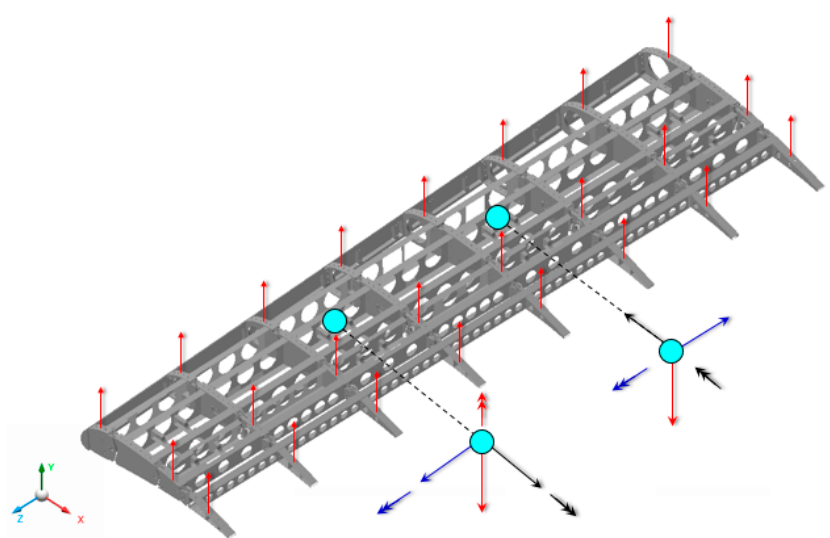
Figure 20. FBD representation: applied loads and constraints forces and moments.